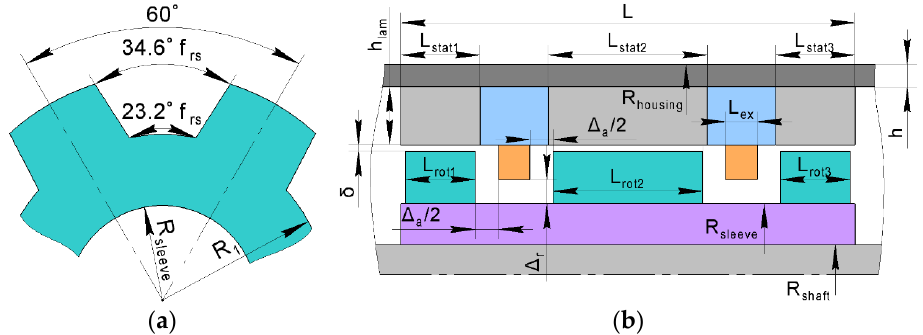
Figure 3. Geometric parameters of the SHM: ( a ) rotor radial dimensions; ( b ) stator and rotor axial and radial dimensions. Table 2. Some geometric parameters of the SHM that were not varied during the optimization. Parameter Value [4]